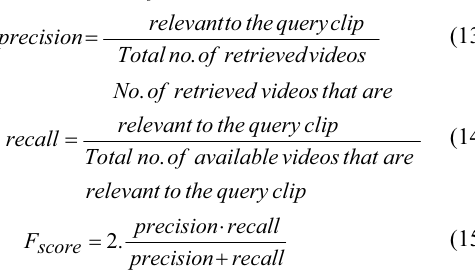
Fig. 6.2 (b) Results of the proposed CBVR system over 3D animation database: (i) input query clip and (ii) some of the